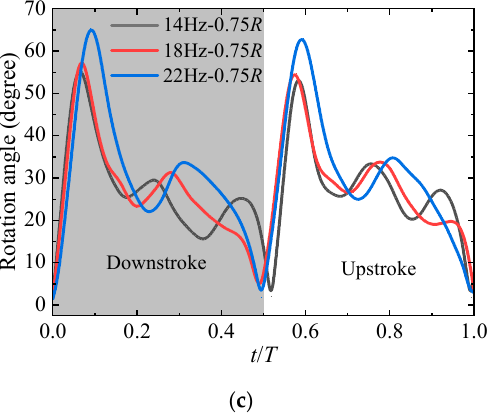
Figure 10. Wing deformation of PET-38 at 14 Hz, 18 Hz, and 22 Hz. ( a ) The rotation angles at 0.25 R ; ( b ) The rotation angles at 0.5 R ; ( c ) The rotation angles at 0.75 R . The effect of flapping frequency on the wing deformation can also be seen from the cycle-averaged rotation angle presented in Figure 11. The cycle-averaged rotation angle was calculated by averaging the rotation angle over a flapping period, and can be defined as: